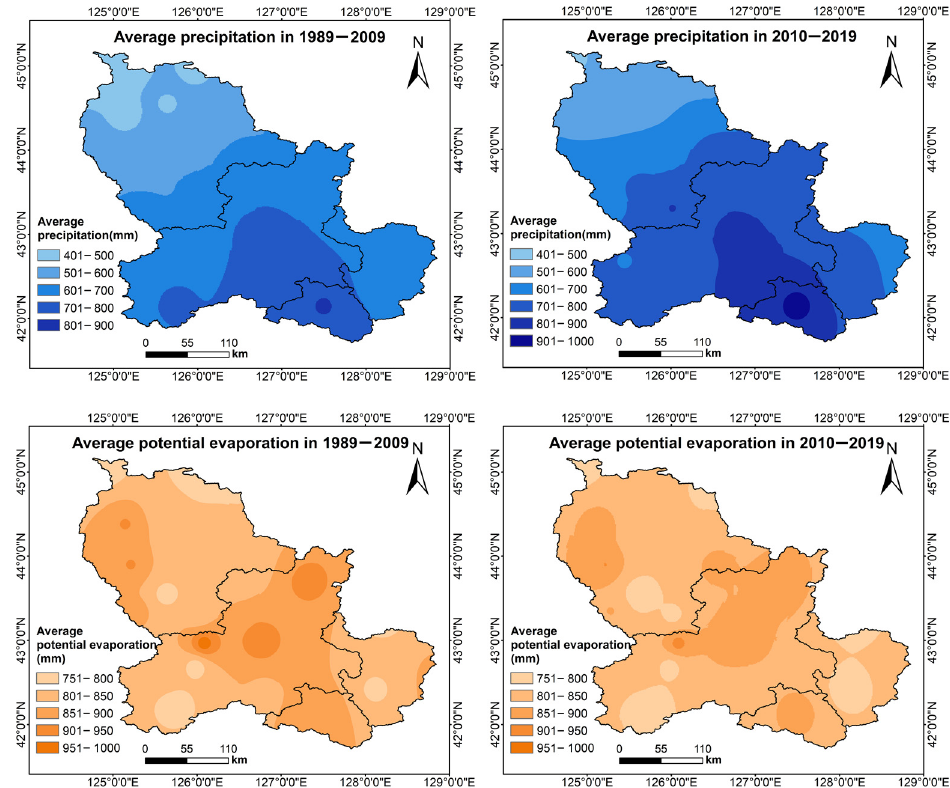
Figure 4. Spatial distribution map of precipitation and potential evapotranspiration in the baseline and disturbed periods of the SSR basin.